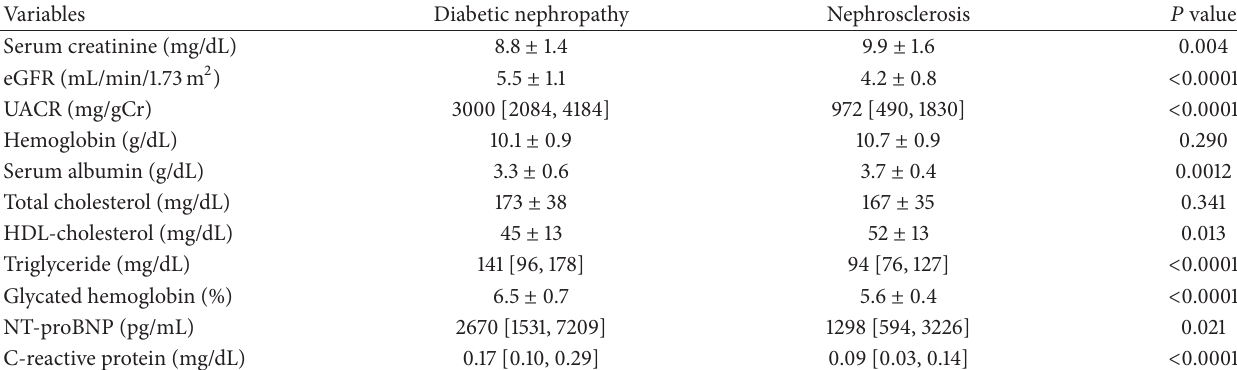
Table 3: Laboratory data before the initiation of RRT in the two groups.